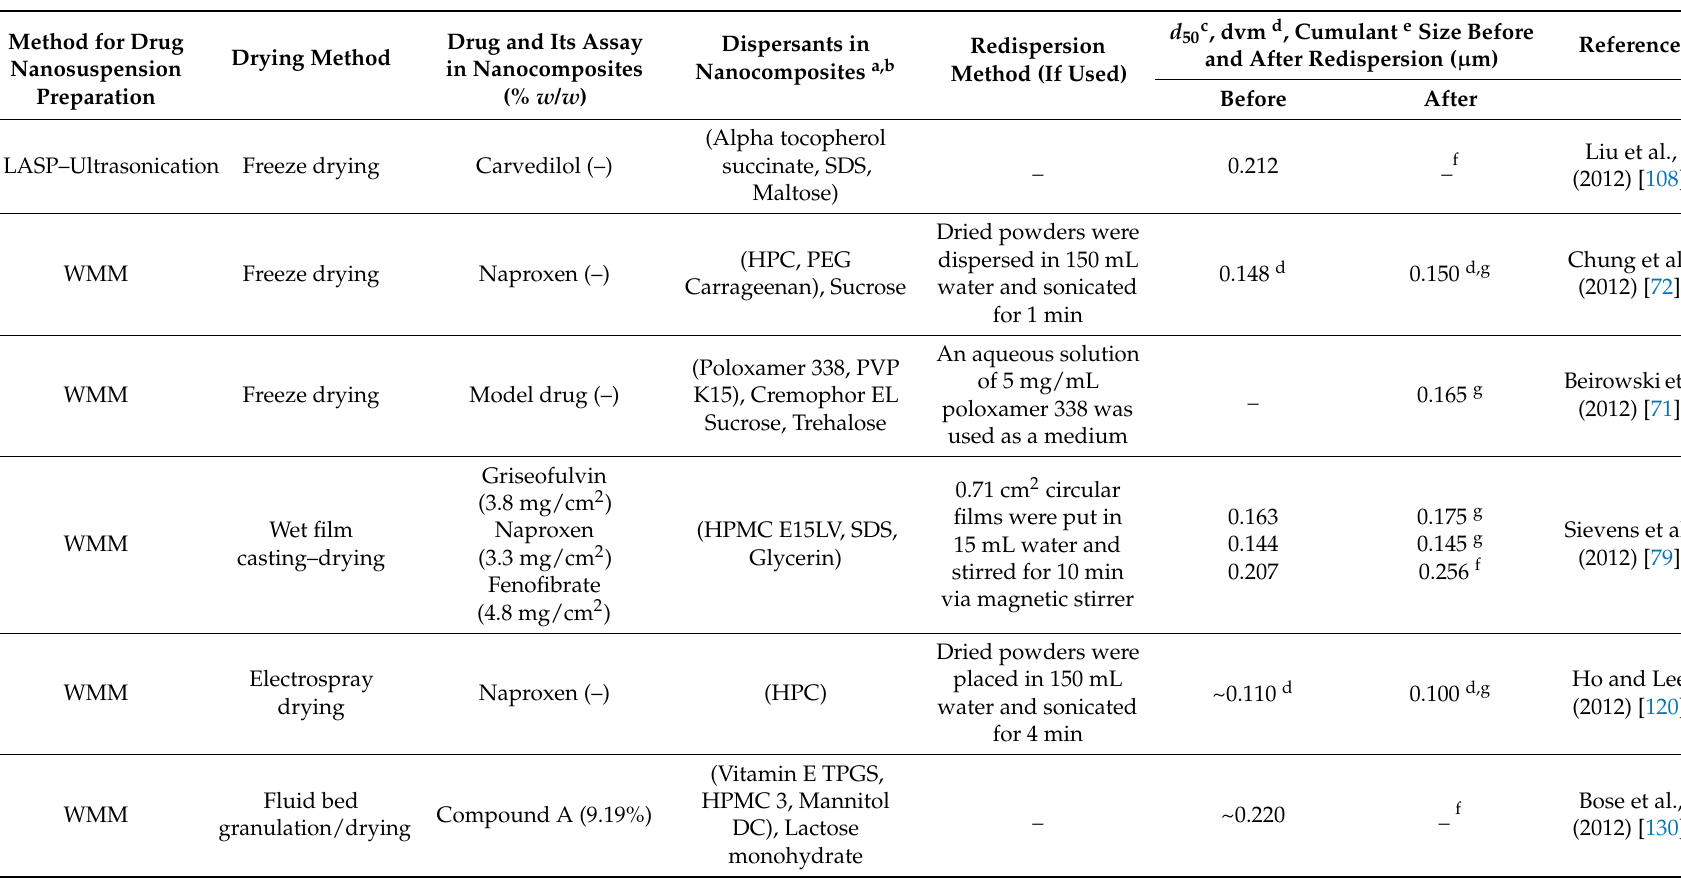
Table 2. Review of recent literature (2012–2017) regarding the preparation methods used for drug nanosuspension preparation, drying methods used for